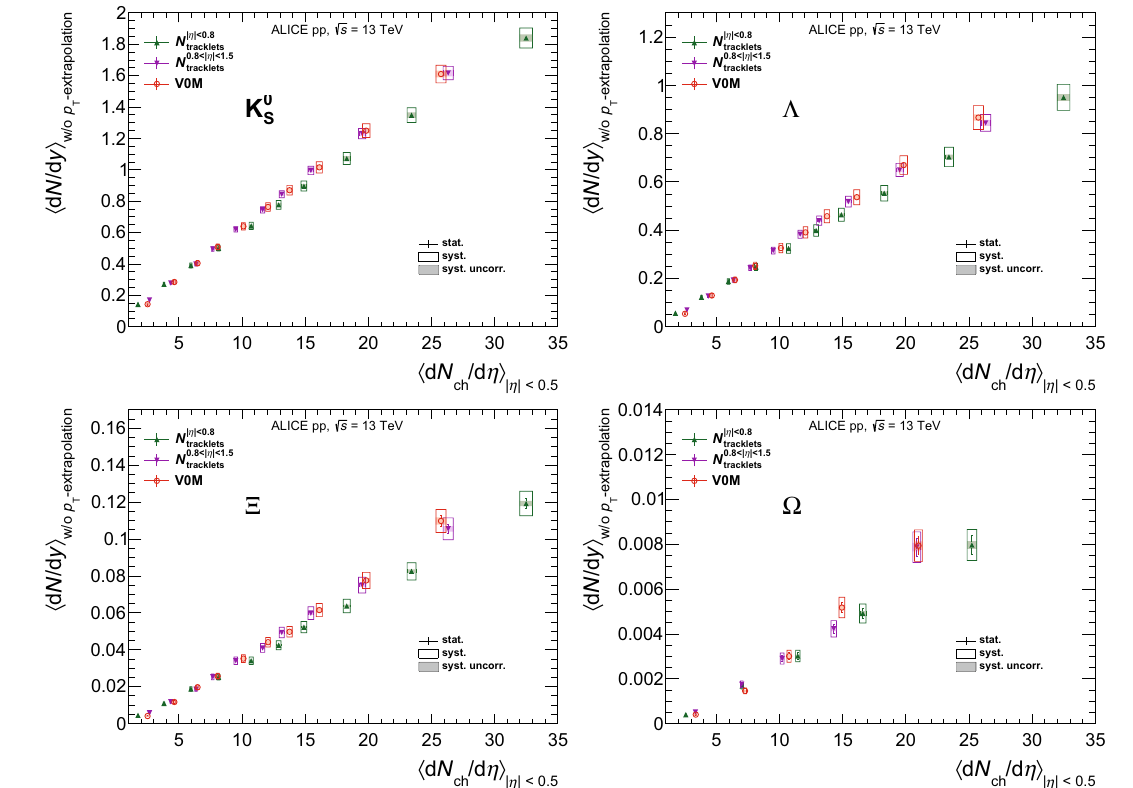
Fig. 9 d N / d y (integrated over the measured p T ranges 0–12, 0.4–8, different multiplicity classes (see text for details). Error bars and boxes 0.6–6.5 and 0.9–5.5 GeV / c for K 0 represent statistical and total systematic uncertainties, respectively. The , (cid:3) , (cid:4) − and (cid:5) − , respectively) as a S bin-to-bin systematic uncertainties are shown by shadowed boxes functionofmultiplicityfordifferentstrangeparticlespeciesreportedfor